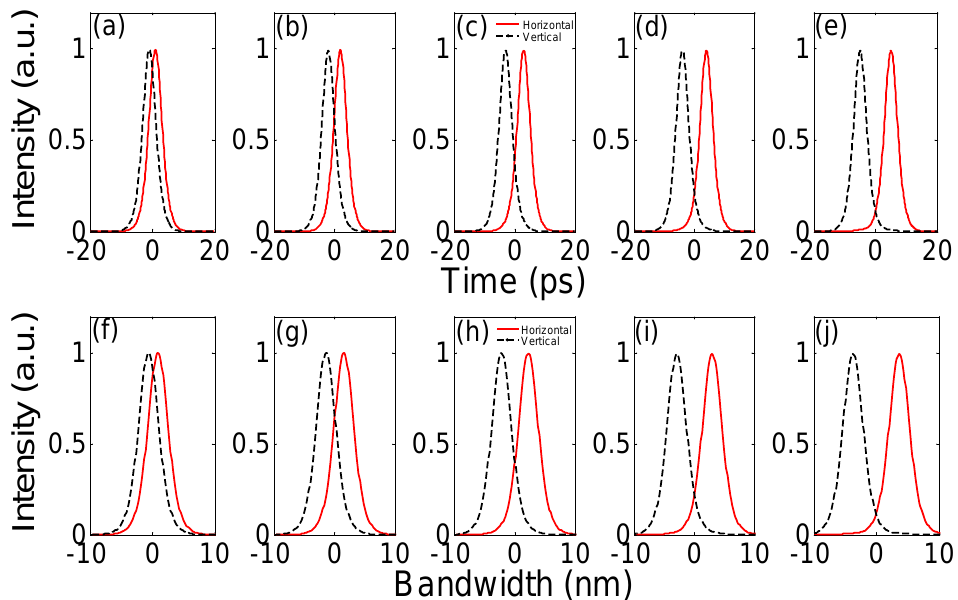
Figure 4. Theoretical results after polarization splitting when the time delay is changed and λ 1 = λ 2 = 1064 nm.